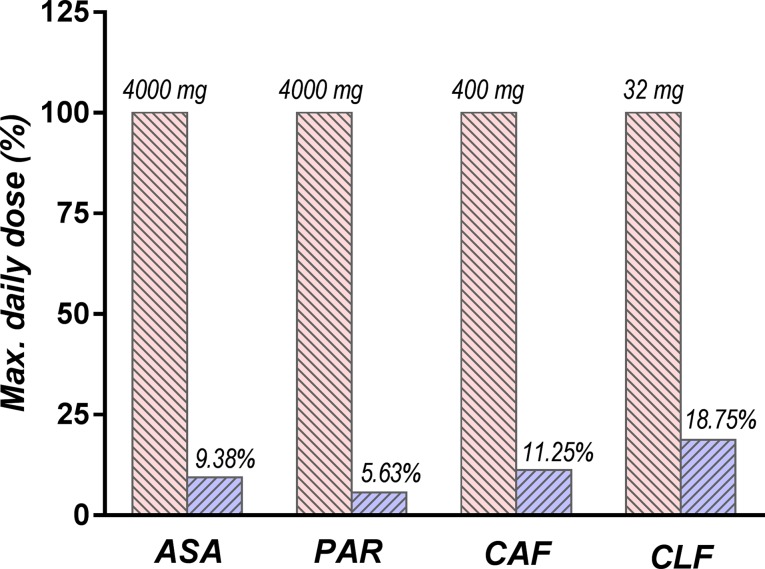
Comparison between daily doses of active components used in the study (depicted in blue) and the maximum doses recommended by the current guidelines (depicted in red).